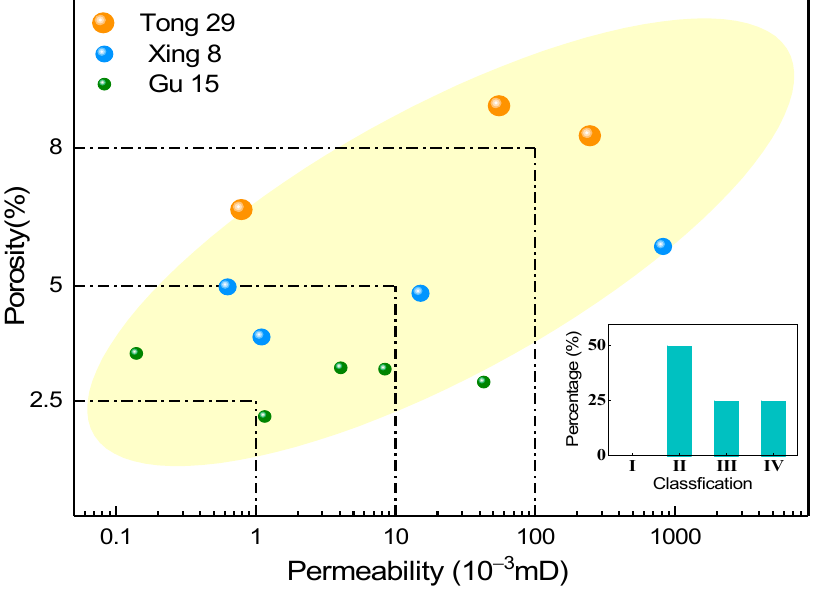
Figure 8. Relationship between porosity and permeability of caprock and its classification.